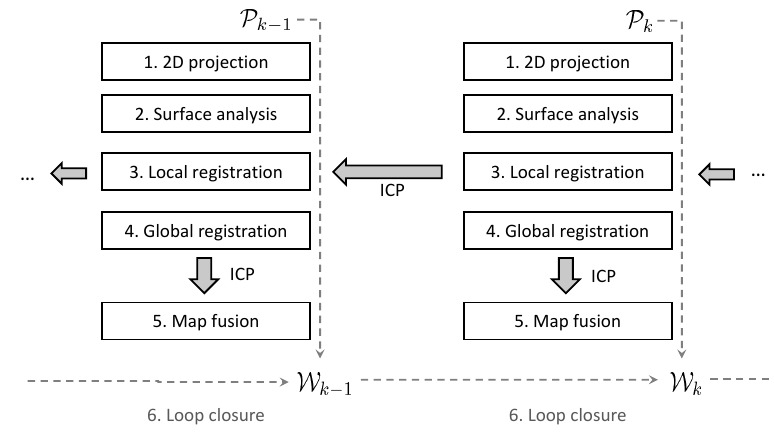
Figure 6. Overview of the system, which is implemented as an incremental process. Every time a consecutive point cloud P k has arrived, it is first projected on a 2D grid (Step 1). Next, it is analyzed to obtain some low-level surface features (Step 2), after which it is aligned (registered) with the point cloud P k − 1 acquired during the previous sweep k − 1 (Step 3). The obtained transformation serves as an initial guess to subsequently align P k with the current world model W k − 1 (Step 4) and to fuse them together to form W k (Step 5). This fusion consists of re-sampling the point cloud by means of a surface reconstruction technique. Optionally, when a loop has been detected, loop closure is performed to cope with the drift and to preserve global consistency (Step